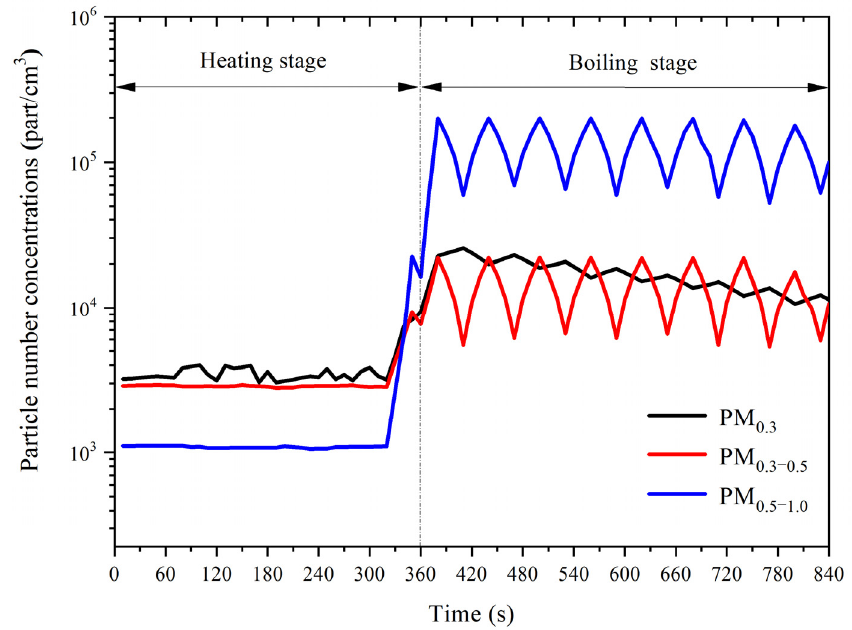
Figure 1. Variations of particle number concentrations during boiling water.